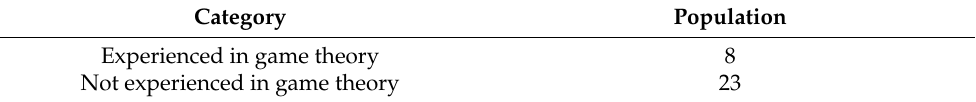
Table 1. The population of the study: experienced vs. not experienced in game